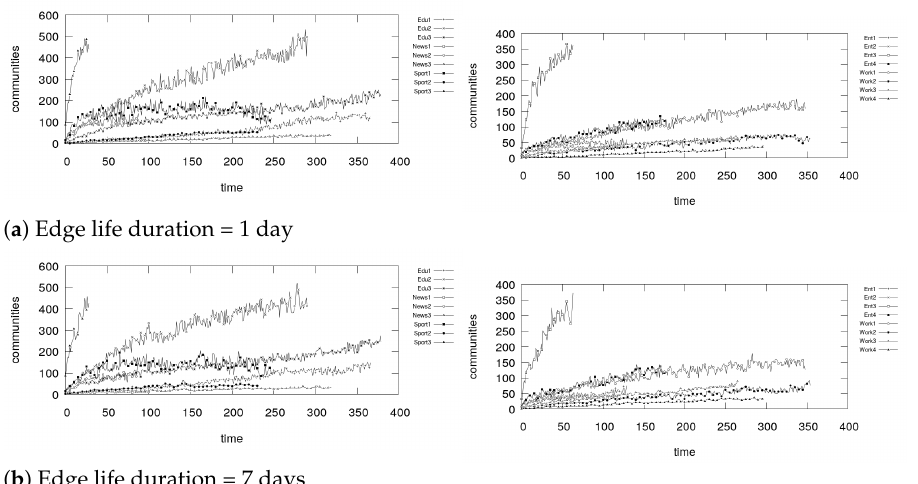
Figure 9. Number of communities detected by